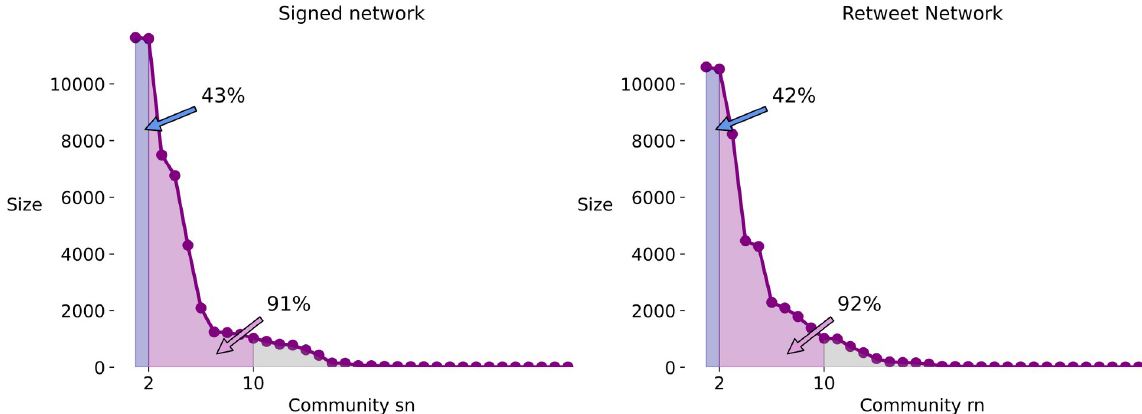
Fig 4. Community sizes. The distribution of sizes of the communities in the signed network (left) and retweet network (right). The tail is cut- off (displaying only communities with more than 10 members) for the sake of legibility. This figure shows that the two networks feature a similar community structure.